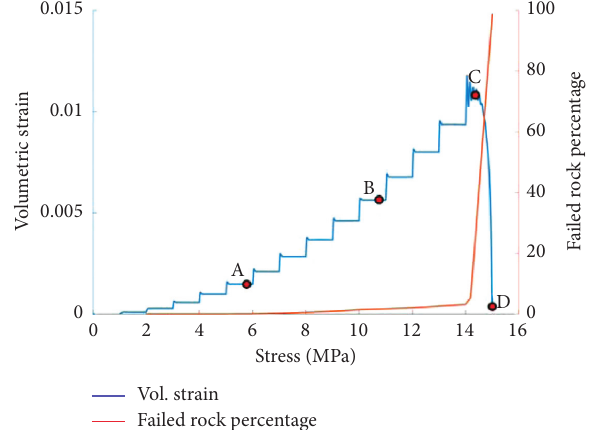
Figure 7: TWC test loading curve (solid blue) and the failed rock volume percentage curve (solid green) during the loading process for the intact rock